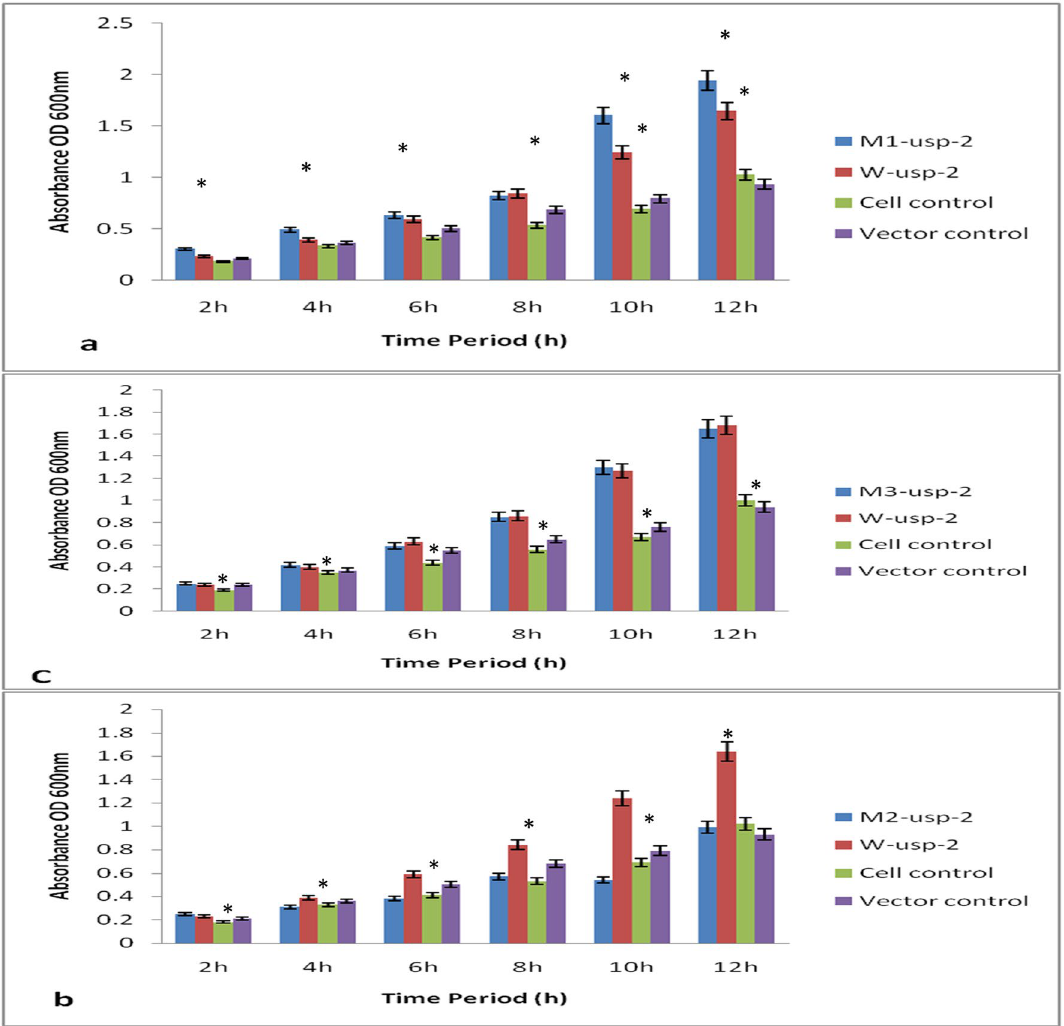
Figure 5. Osmotic stress tolerance in E. coli BL-21 , ( a ) E. coli BL-21 BL-21-uspABC expressing M1-usp-2 showed significant tolerance as compared to vector control, cell control and W-usp-2 gene expressing cells, ( b ) W-usp-2 gene expressing BL-21-uspABC cells are more tolerant as compared to M2-usp-2 cloned cells of E. coli , ( c ) OD of BL-21-uspABC cells expressing M3-usp-2 gene is almost similar to BL-21-uspABC mutant cells expressing W-usp-2